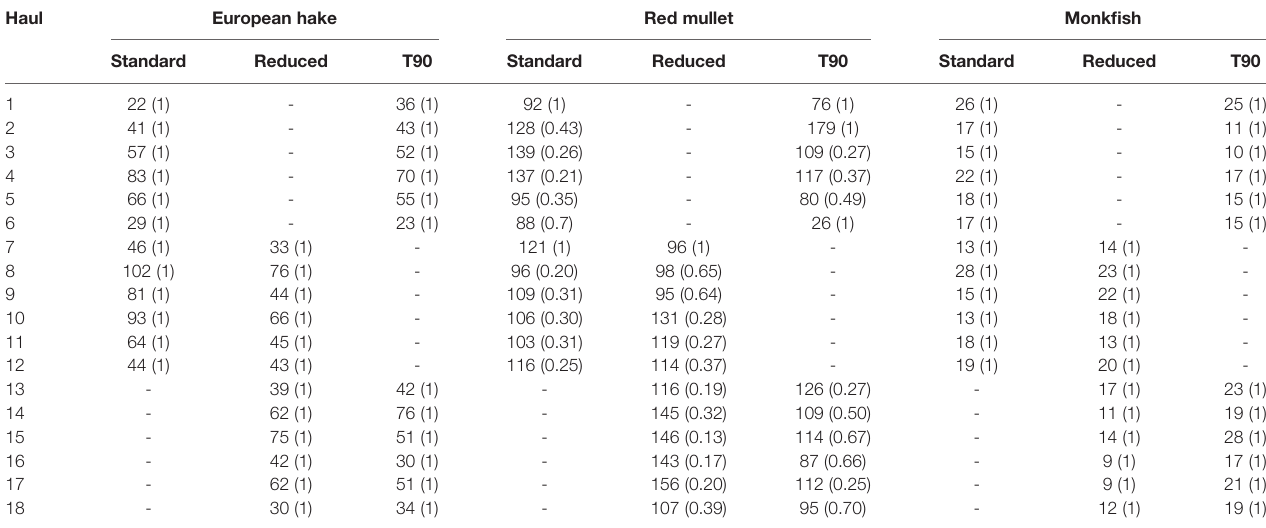
Values in parentheses are the subsampling